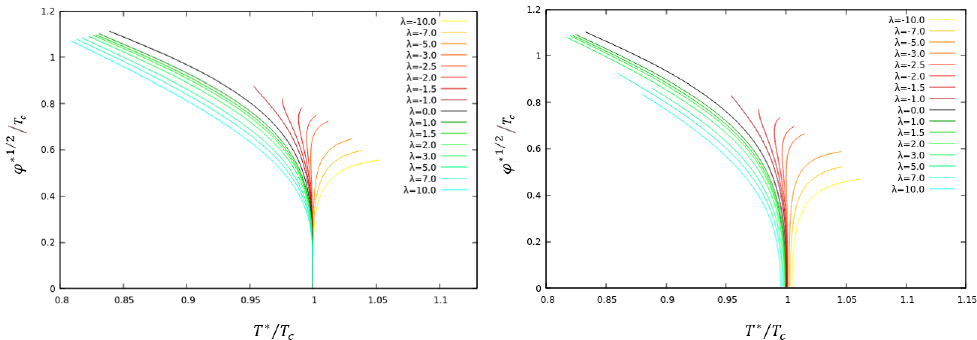
Figure 2. The condensate ϕ 1/2 + / T c as a function of T ∗ / T c for (cid:101) = 0 and several values of λ . We show the balanced case with ρ 1 = ρ 2 ( left ) and the unbalanced case with ρ 1 (cid:54) = ρ 2 ( right ). Note that the curves stop due to increased numerical difficulty to find a solution. Although the derivatives of some of the functions for negative λ seem to diverge, we believe that all curves (if completed by improved numerics) have finite derivatives